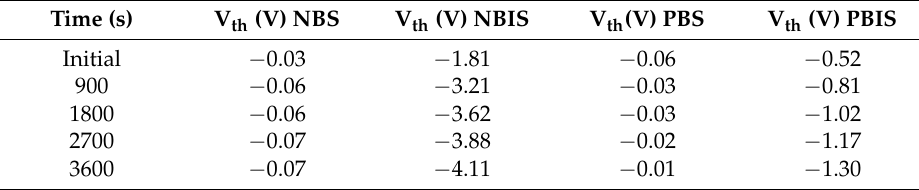
Table 2. Summary of the V th of the coplanar top-gate TFTs under various bias stress. Time